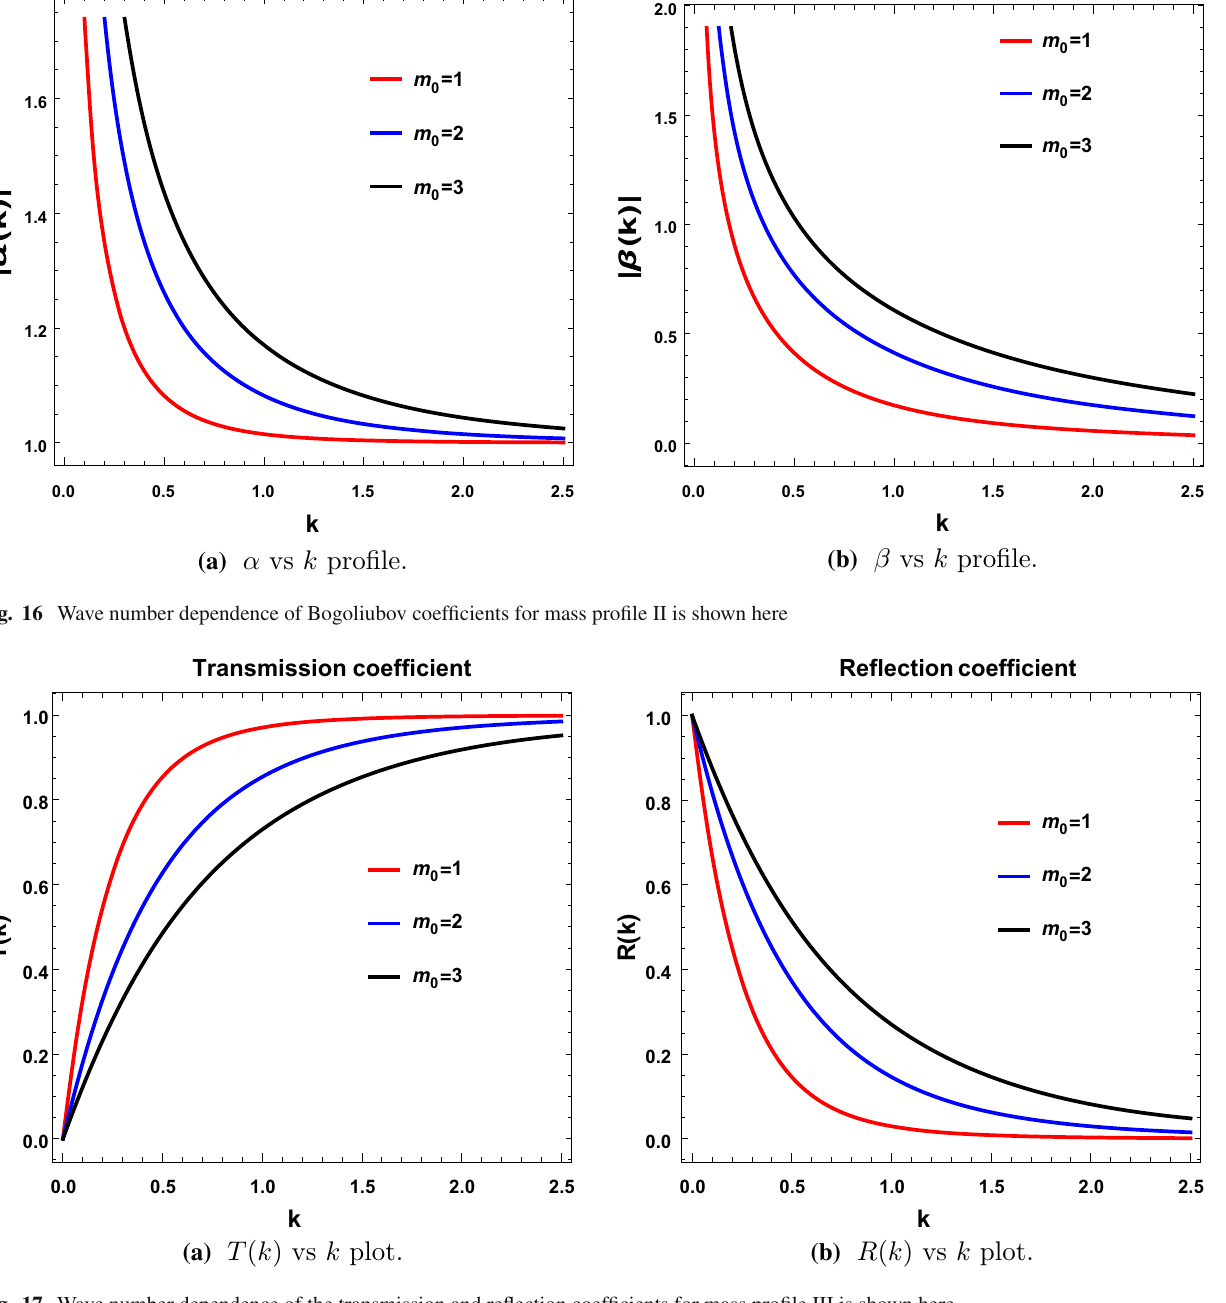
Fig. 17 Wave number dependence of the transmission and reflection coefficients for mass profile III is shown